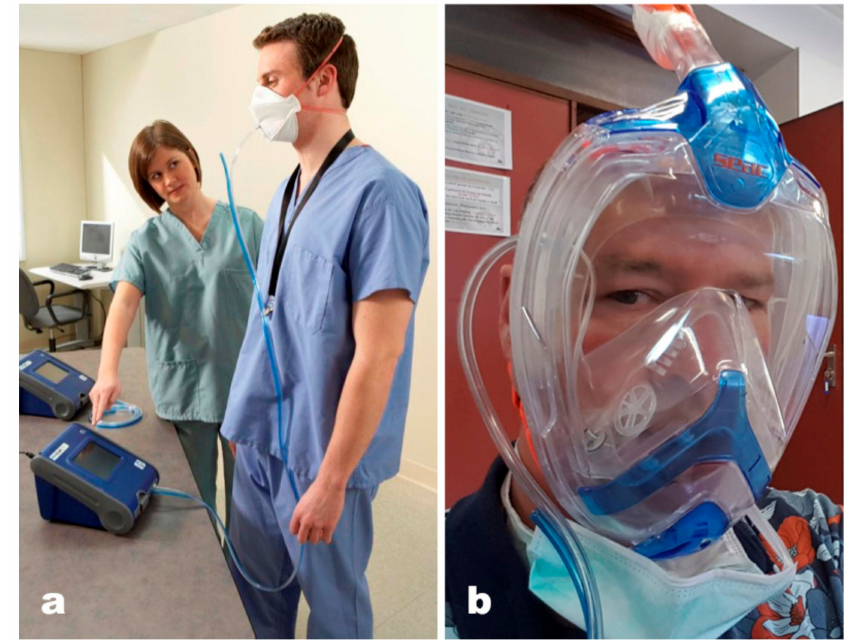
Figure 3. Particle count sampling setup. ( a ) (from [12]) general setup; ( b ) sampling tube fitted inside snorkel mask towards nose and mouth breathing chamber. Blue tubing—ambient air sampling line, transparent tubing—mask sampling